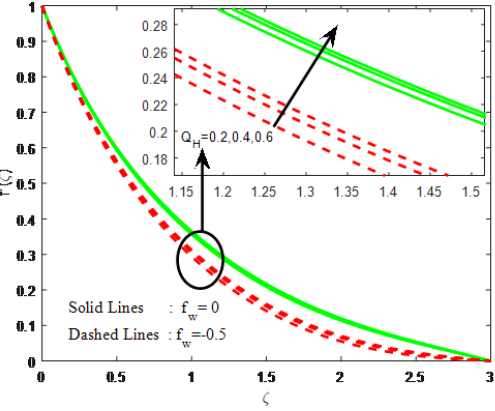
Fig. 7: The effect of Biot number Bi on temperature